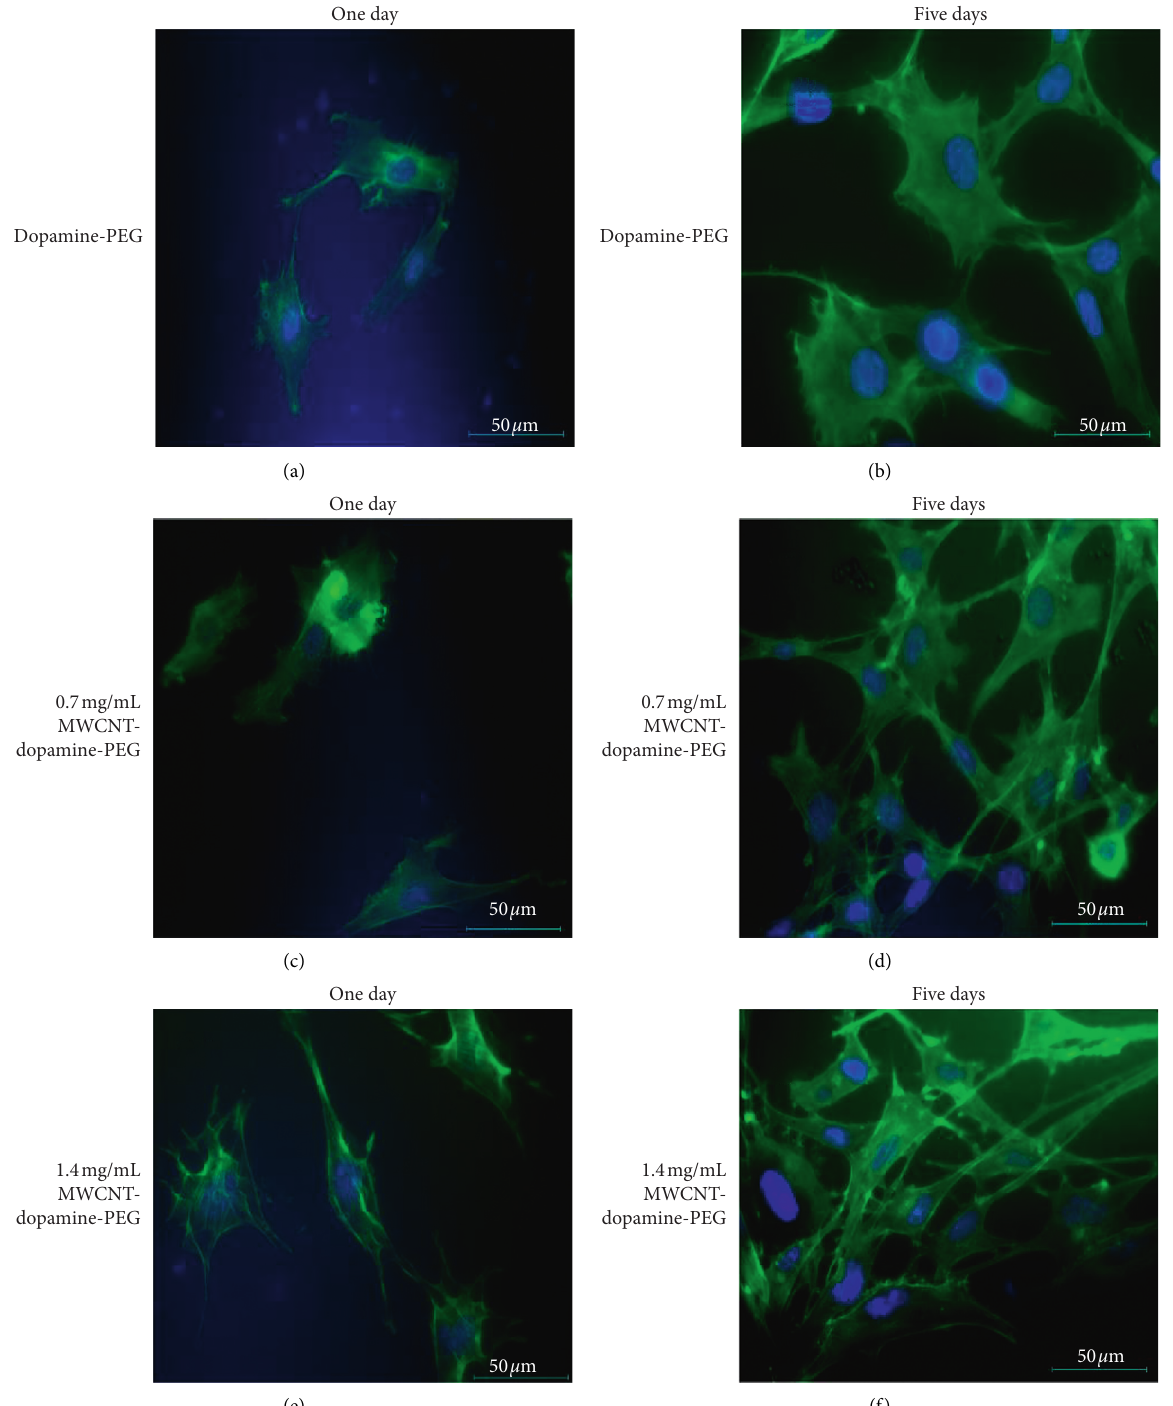
Figure 2: BMSCs were cultured on hydrogels with different concentrations of MWCNTto examine the effect of MWCNTconcentration on cell morphology. Green represents the cytoskeleton and blue represents the nucleus